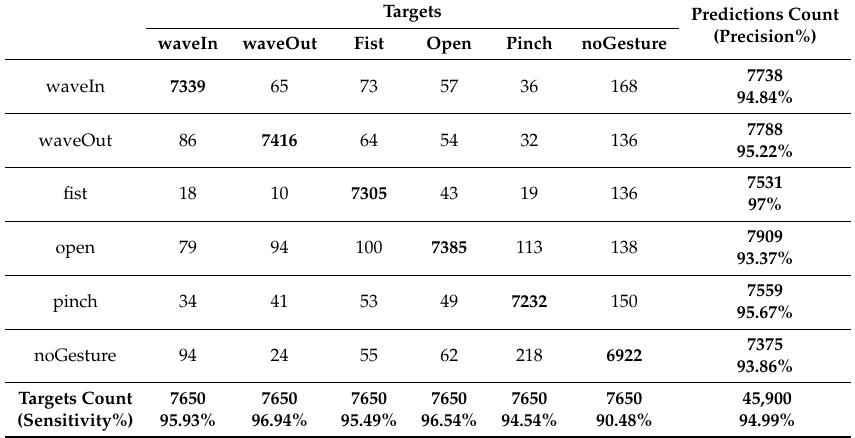
Table 3. Confusion matrix of experiment 1 for the user-specific model. Rotation of the bracelet = NO , orientation correction = NO . The sync gesture was not used. Classification accuracy =